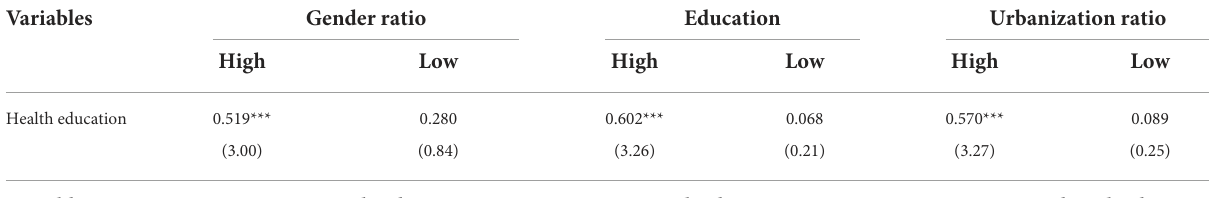
TABLE 6 Heterogeneity analysis of the impact of health education on health insurance.